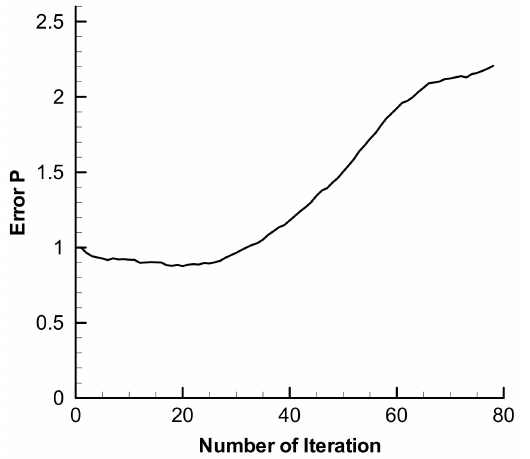
Figure 13. Variations of the residual of pressure differences for the first design case by the UESA with the spine constraint applied.